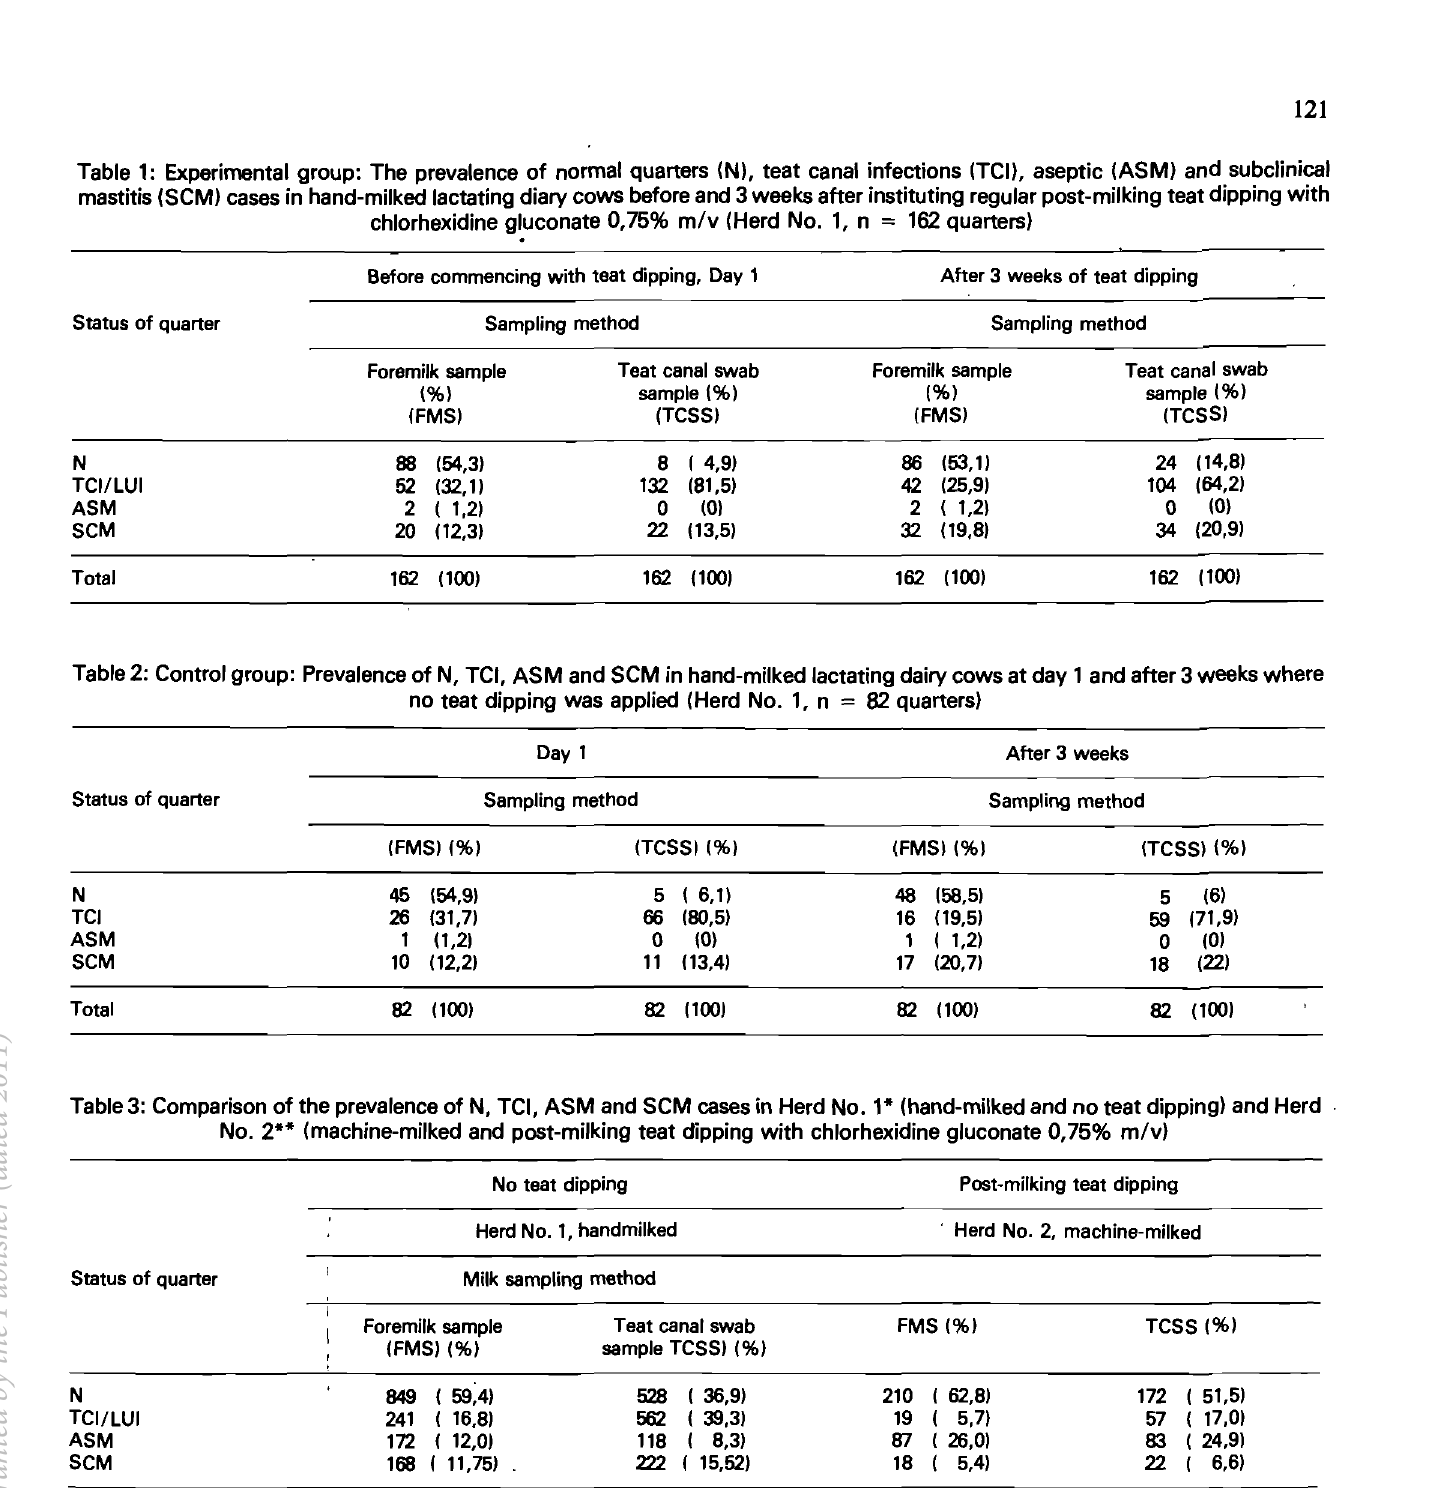
Table 1: Experimental group: The prevalence of normal quarters (N), teat canal infections (TCI), aseptic (ASM) and subclinical mastitis (SCM) cases in hand-milked lactating diary cows before and 3 weeks after instituting regular post-milking teat dipping with